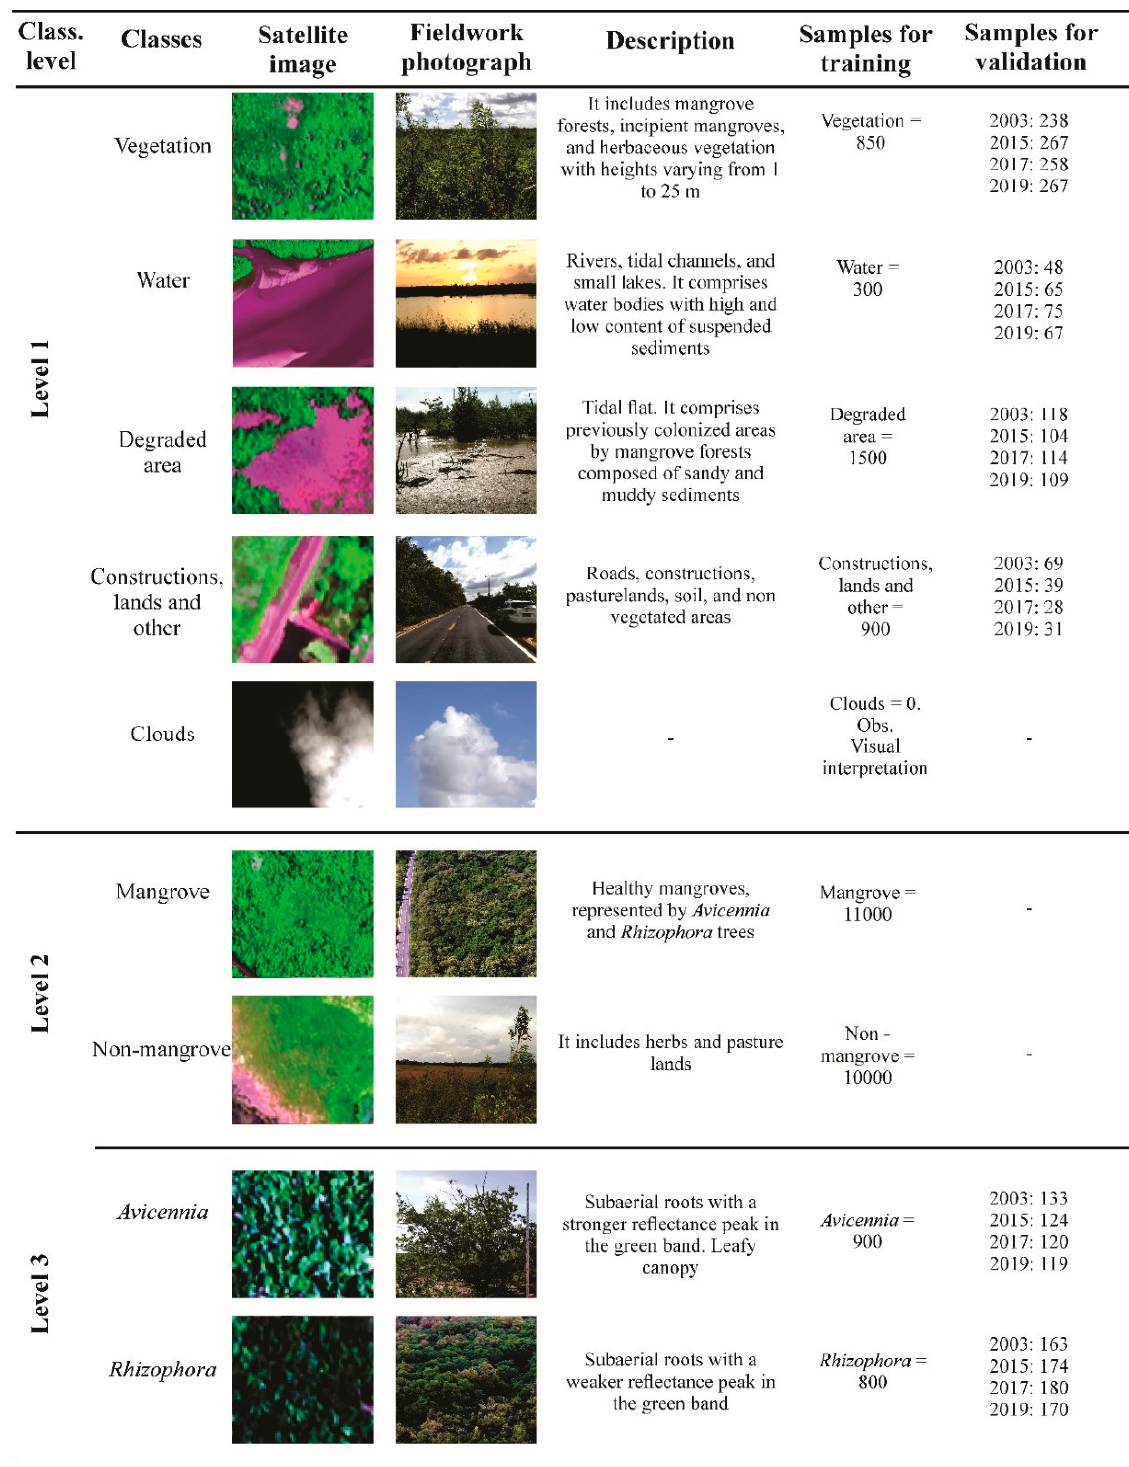
Figure 4. Description of high-resolution classification in this study. Every object with NDWI values greater than zero was classified as water, and objects with NDVI values greater than 0.5 were classified as vegetation. Cloud class was manually interpreted. A multiresolution classification was carried out using spectral and geometrical features of objects to individualize the level 1 classes. At level 2, only spectral parameters were considered to separate mangrove from non-mangrove vegetation. NDVI and NIR bands showed to be especially useful in differentiating mangroves from other vegetation units